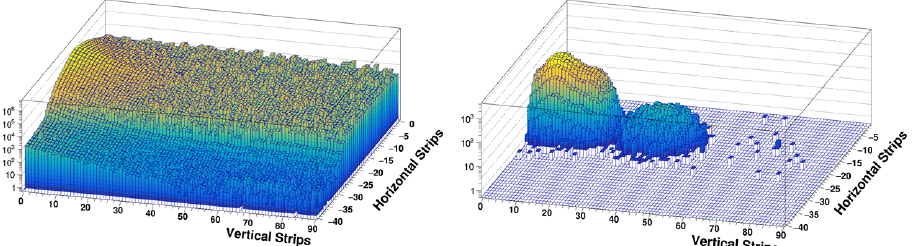
Fig. 4. Position of beam residues measured without (left) and with (right) selection of scattered protons detected in the telescope. In the right figure , 208 Pb 82+ nuclei that de-excite by  emission are in the left bump, while 207 Pb 82+ nuclei produced after neutron emission are located in the right